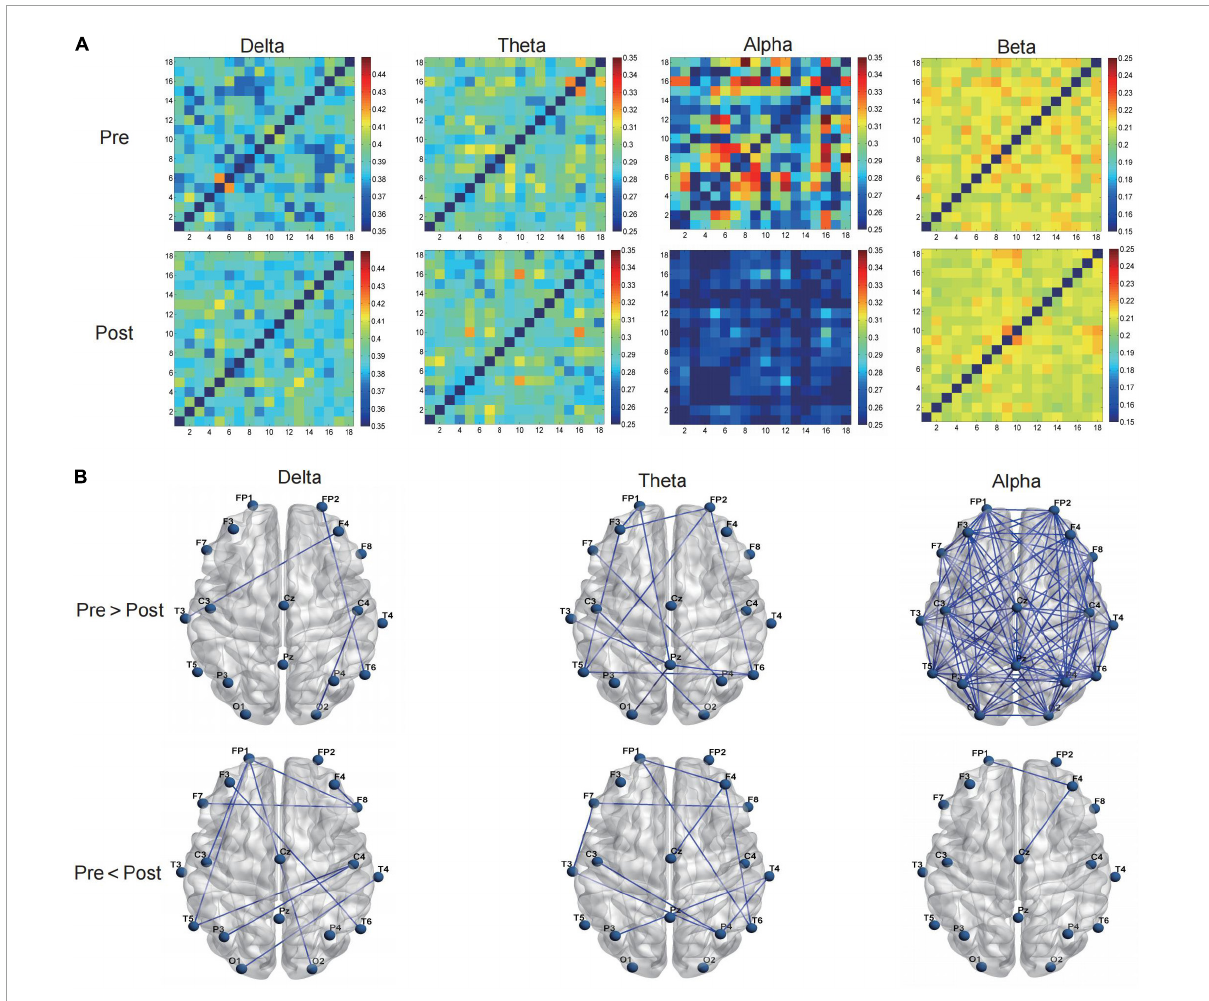
FIGURE7 The control group (A) by regarding phase lag index (PLI) value as the strength, verified 18*18 PLI functional connection moments, calculated global, and local topological parameters (B) on the brain network from the graph